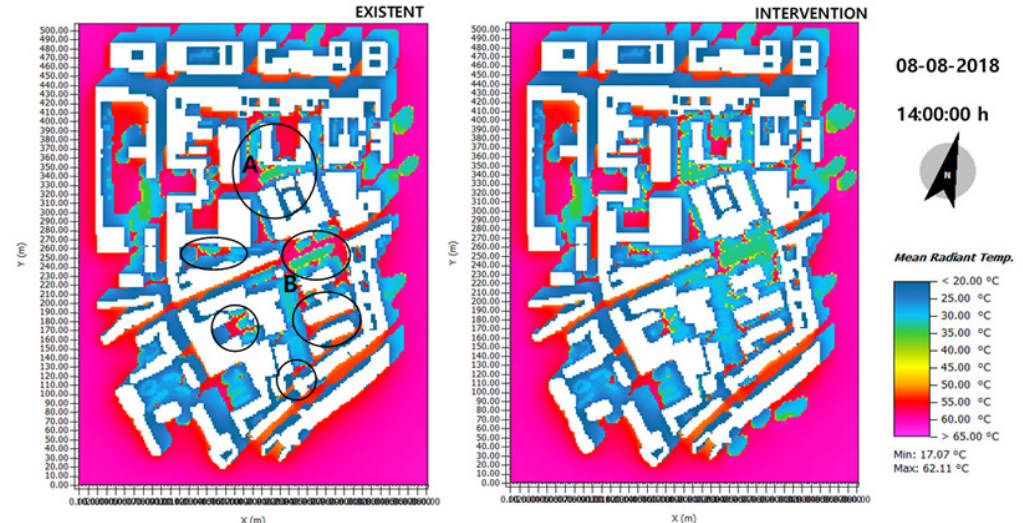
Figure 3. Comparison of the MRT at 1.5 m elevation between the existing state of the case study and the intervention plan generated on ENVI‐met.